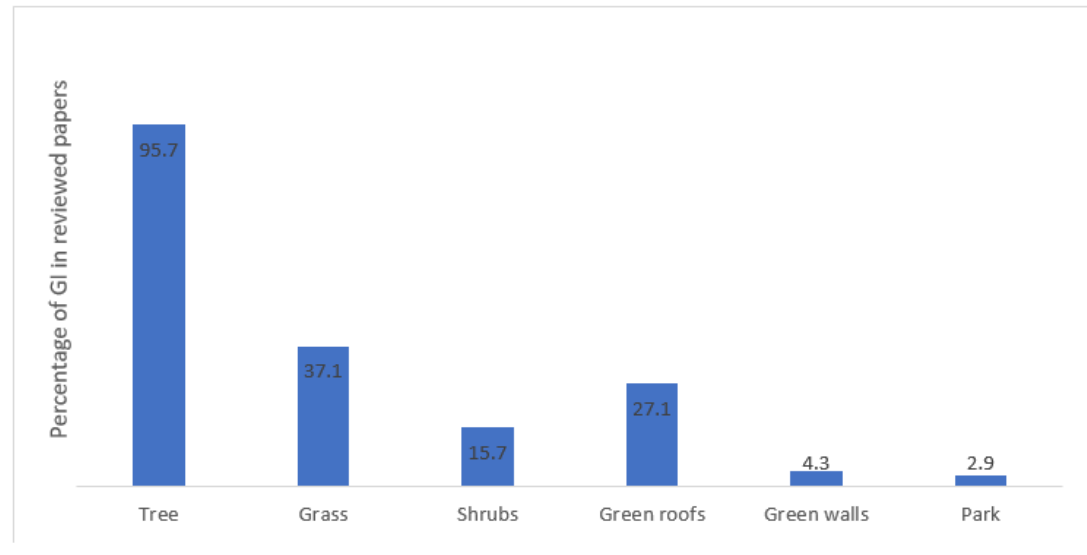
Figure 4. Types of green infrastructure (GI) in the reviewed papers.